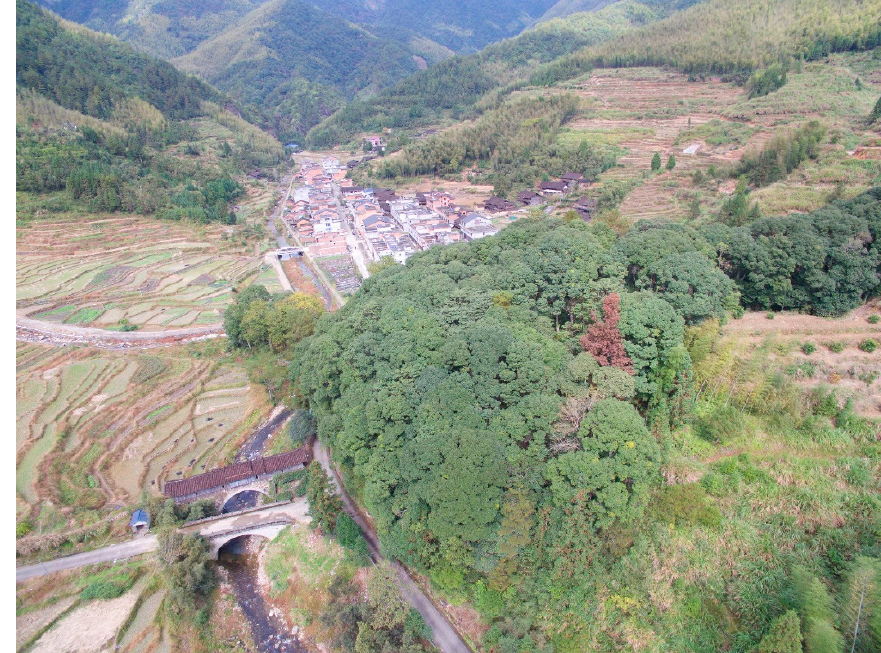
Figure 8. A shuikou (water mouth) fengshui forest below Sanjiaoqiu village, Zhejiang. This view is from downstream and shows a bridge temple in the foreground. (Drone photo by the author, 2018)